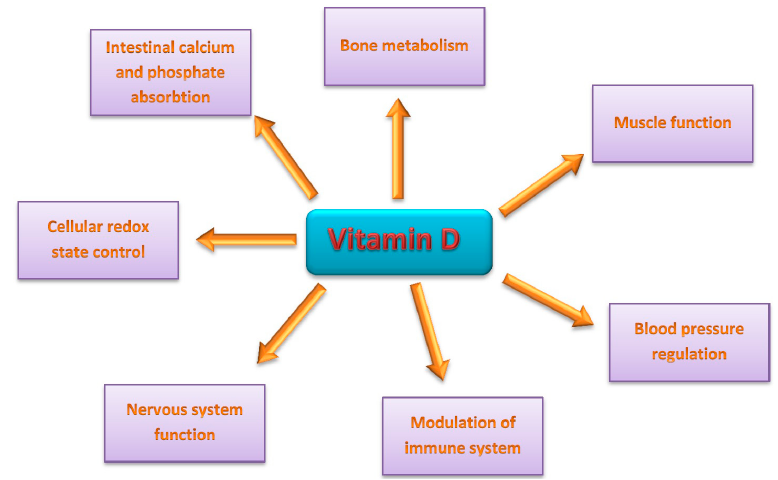
Figure 1. Multiple functions of vitamin D.